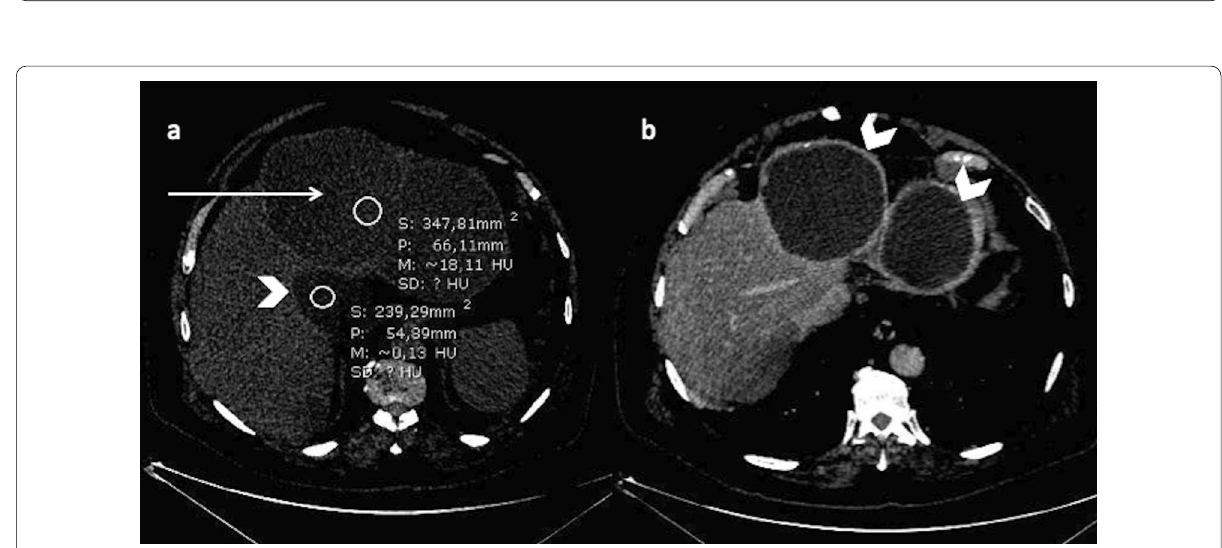
Fig. 13 Infected simple hepatic cysts in a 77-year-old male with autosomal dominant polycystic liver disease. a Axial non-enhanced computed tomography shows two cysts under pressure (arrow), slightly more attenuating than the non-infected cysts (arrowhead); b with a thick enhanced wall on the portal venous phase